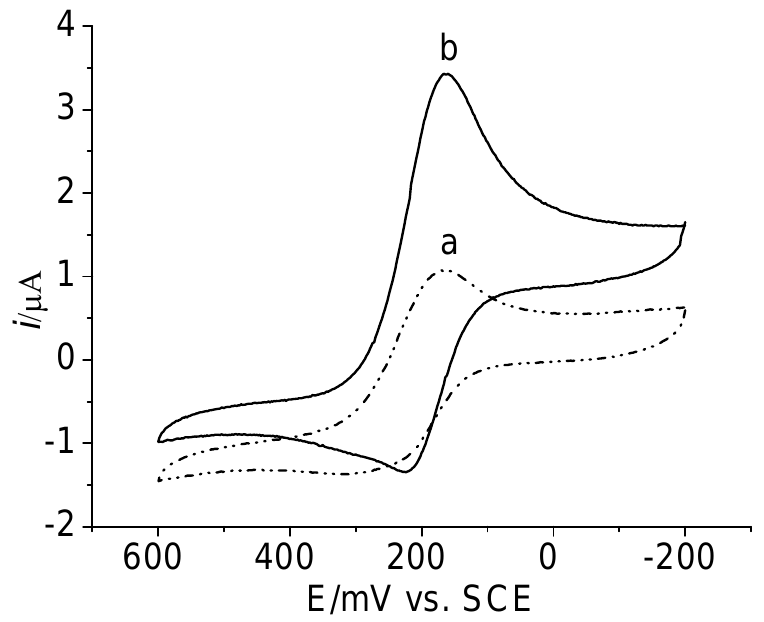
Figure 6. Cyclic voltammograms of CS/Fc electrode (a) and CS/HRP/Fc (b) in 10.0 mL 0.02 M pH 7.0 PBS containing 1.94×10 -4 M H